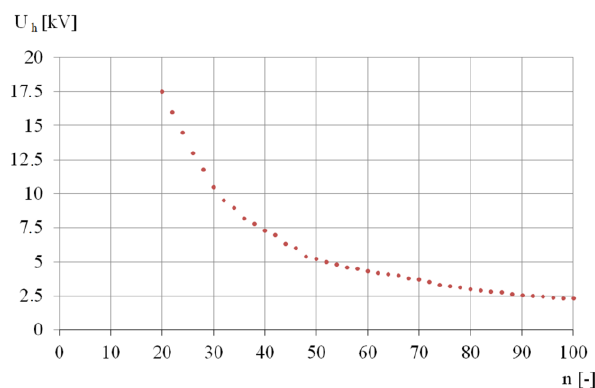
Figure 9. Dependence of the voltage U h on the blade number n.